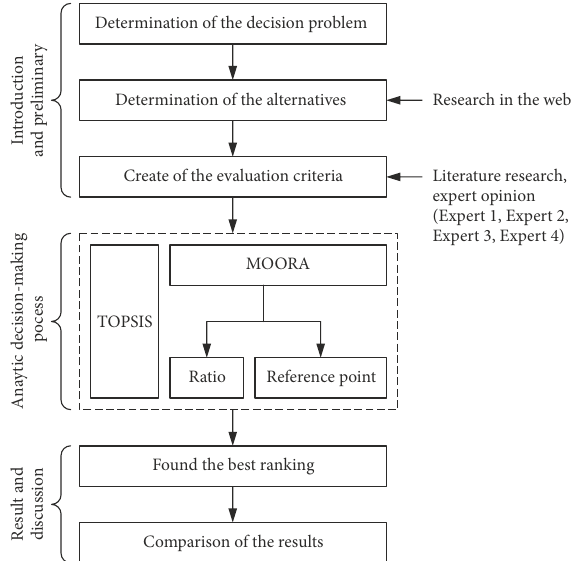
Figure. The flowchart for proposed